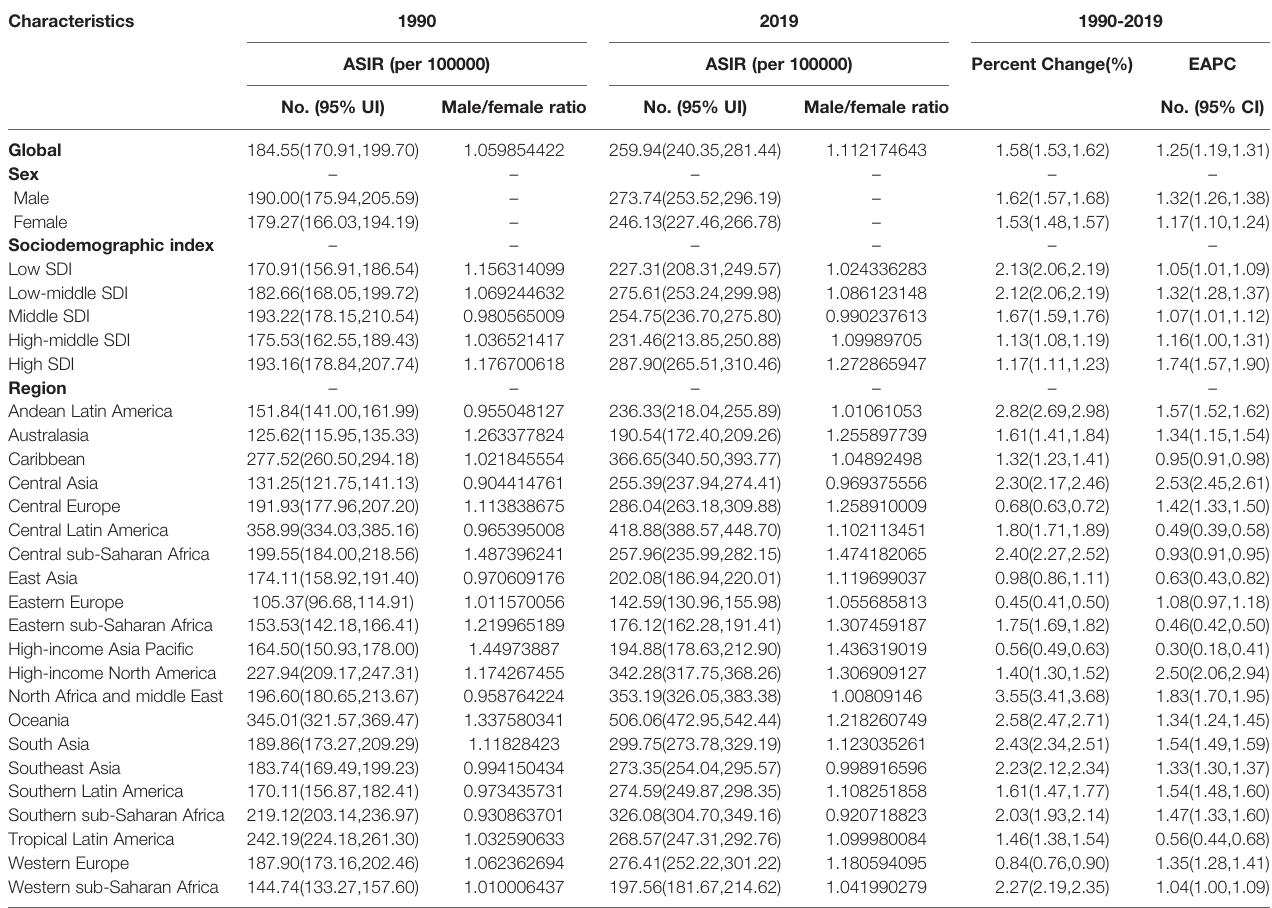
TABLE 1 | The age-standardized incidence rate of T2DM in 1990 and 2019 and its temporal trends.